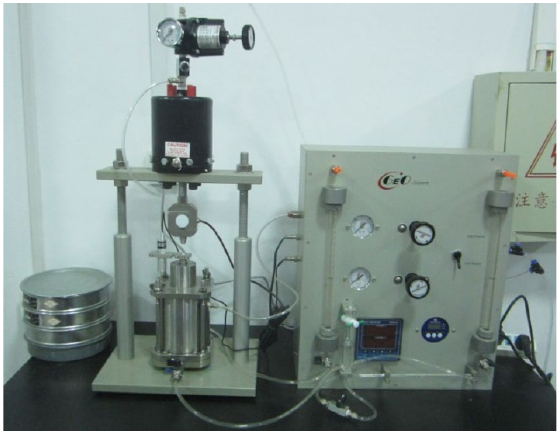
Figure 5. Test system of the soil–water characteristic curve using the pressure plate apparatus.